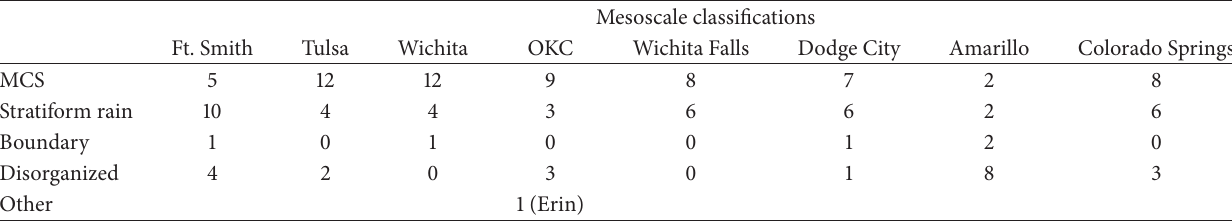
Table 5: Mesoscale classifications of the cases by